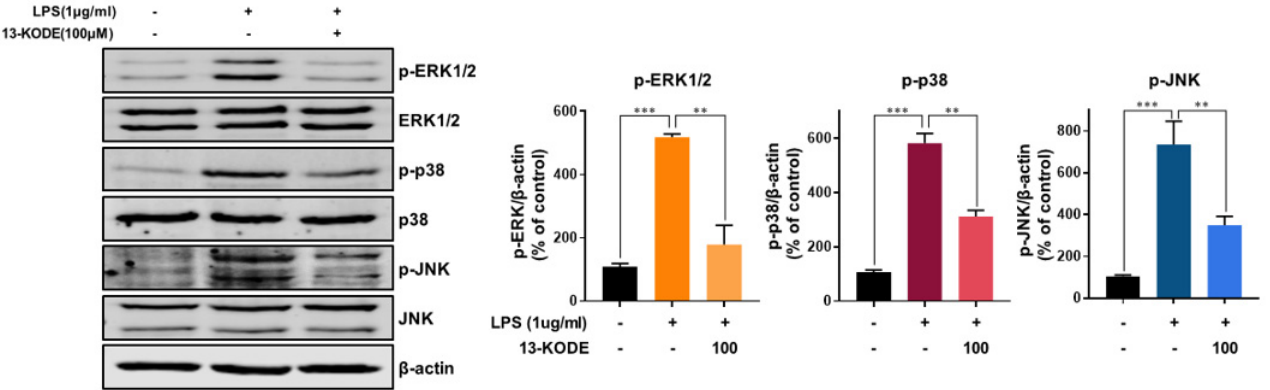
Figure 5. Inhibition of the LPS-induced activation of MAPKs by 13-KODE in RAW 264.7 macro- phages. The cells were treated with 100 µM of 13-KODE for 1 h prior to exposure to LPS (1 µg/mL) for 30 min and total protein was isolated. The protein extracts were subject to SDS-PAGE followed by Western blot analysis using the indicated primary antibodies. The amount of β -actin served as the internal control. pERK1/2, p-p38, and pJNK levels were determined. The values represent the mean ± standard deviation, n = 3. ** p < 0.01; *** p < 0.001.